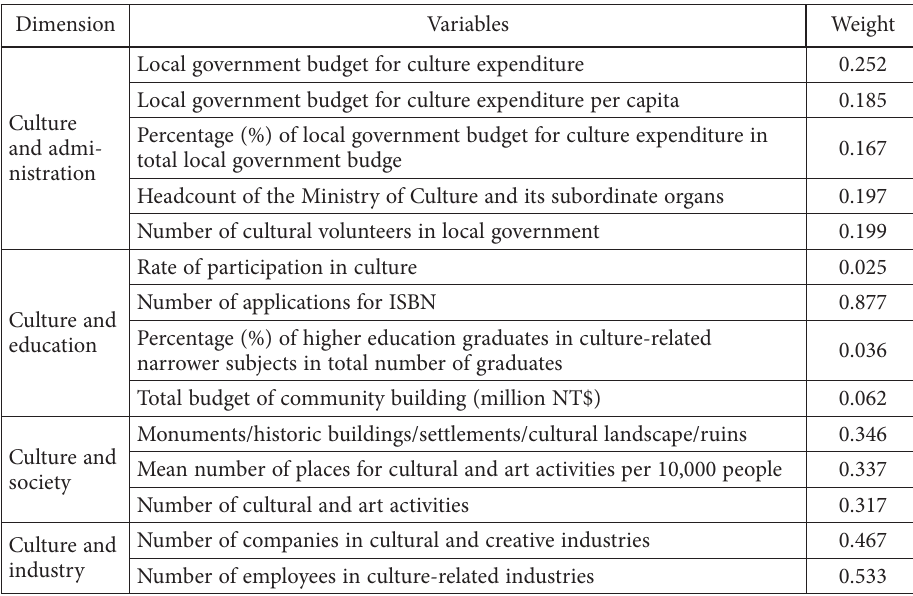
Table 2. Weight of each dimension